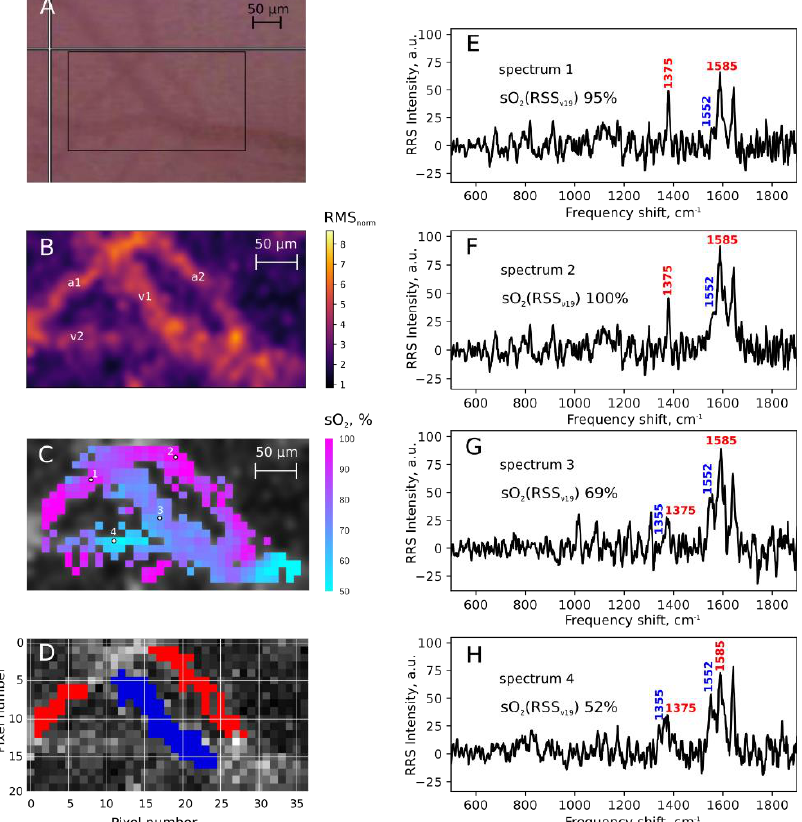
Figure 10. ( A ) Microphotograph of the cortex region in the reflected light with two arterioles and two venules, marked as a1, a2, v1, v2, respectively. ( B ) Raman image of the chosen region and ( C ) Raman map obtained on the basis of ( B ) and showing level of blood saturation with O 2 calculated from Raman spectra in each point of the recorded Raman image ( B ). ( D ) Visualization of regions that were used to calculate average values of blood saturation in arterioles and venules. ( E – H ) Resonance Raman spectra from the points of interest marked by white circles 1–4 in ( C ) on arterioles and venules. Reprinted from [81] with permission from Wiley.